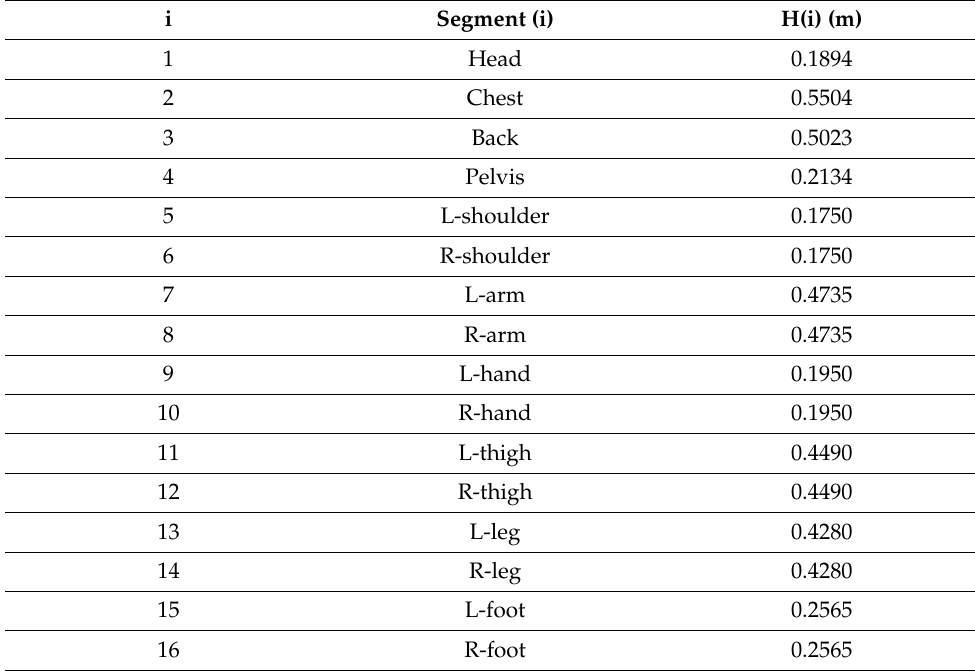
Table 4. H(i) Height of the body segment.